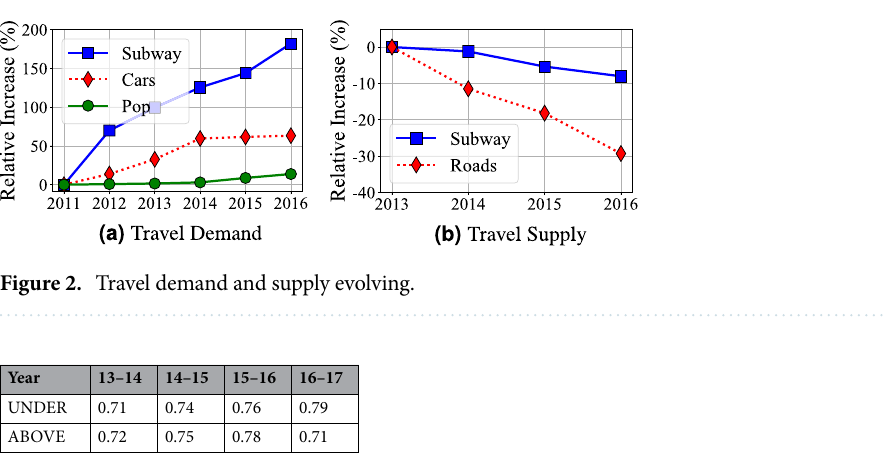
Table 1. Yearly travel delay